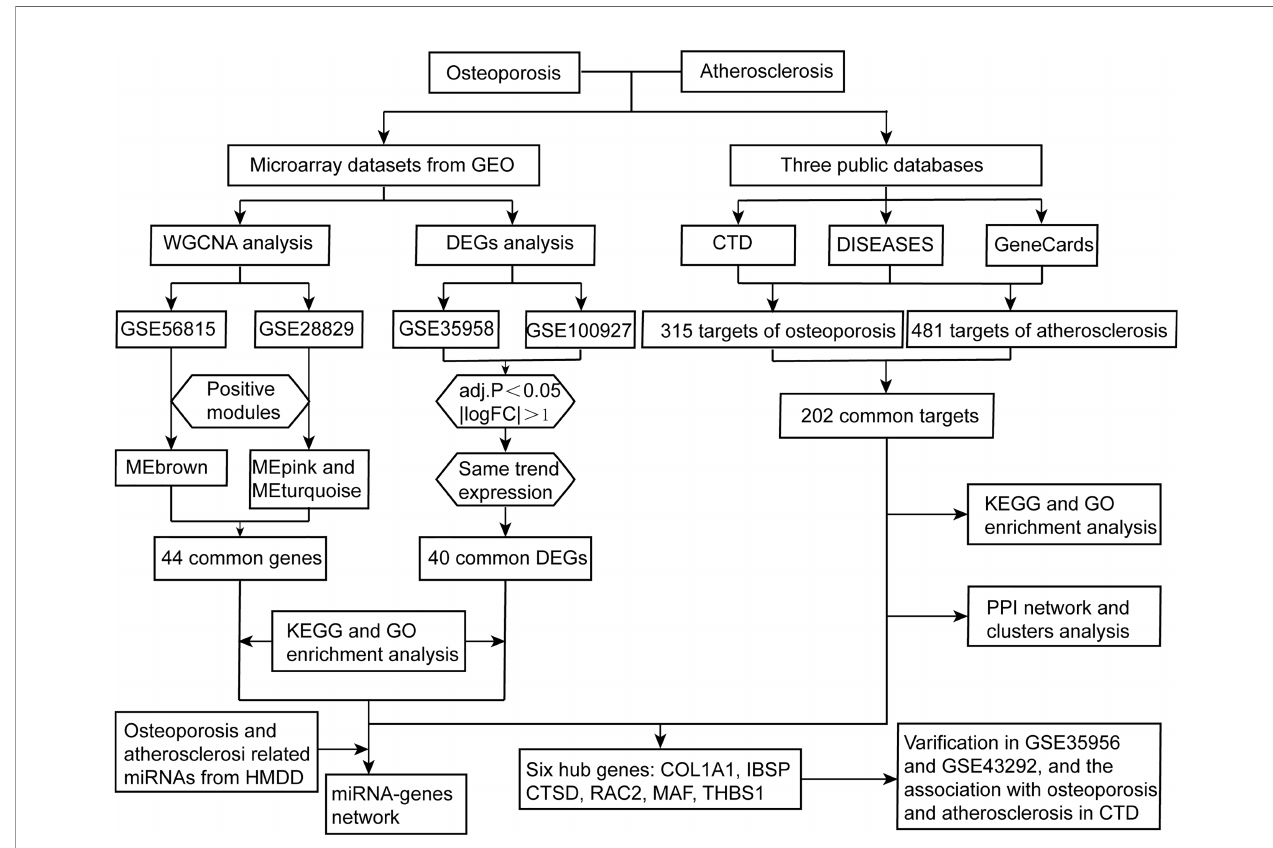
FIGURE 1 | Research design fl ow